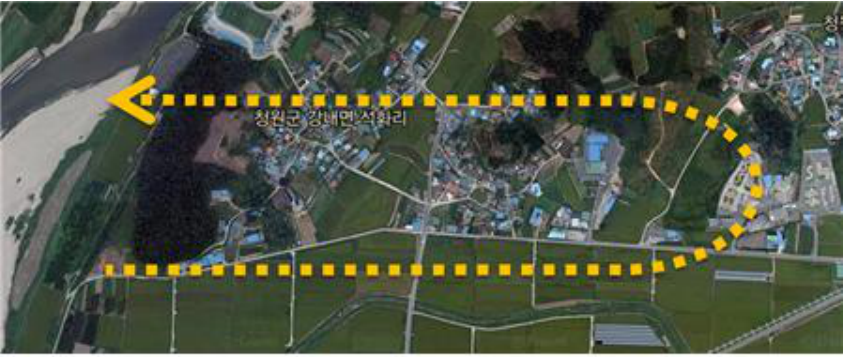
Figure 12. Test site and flight